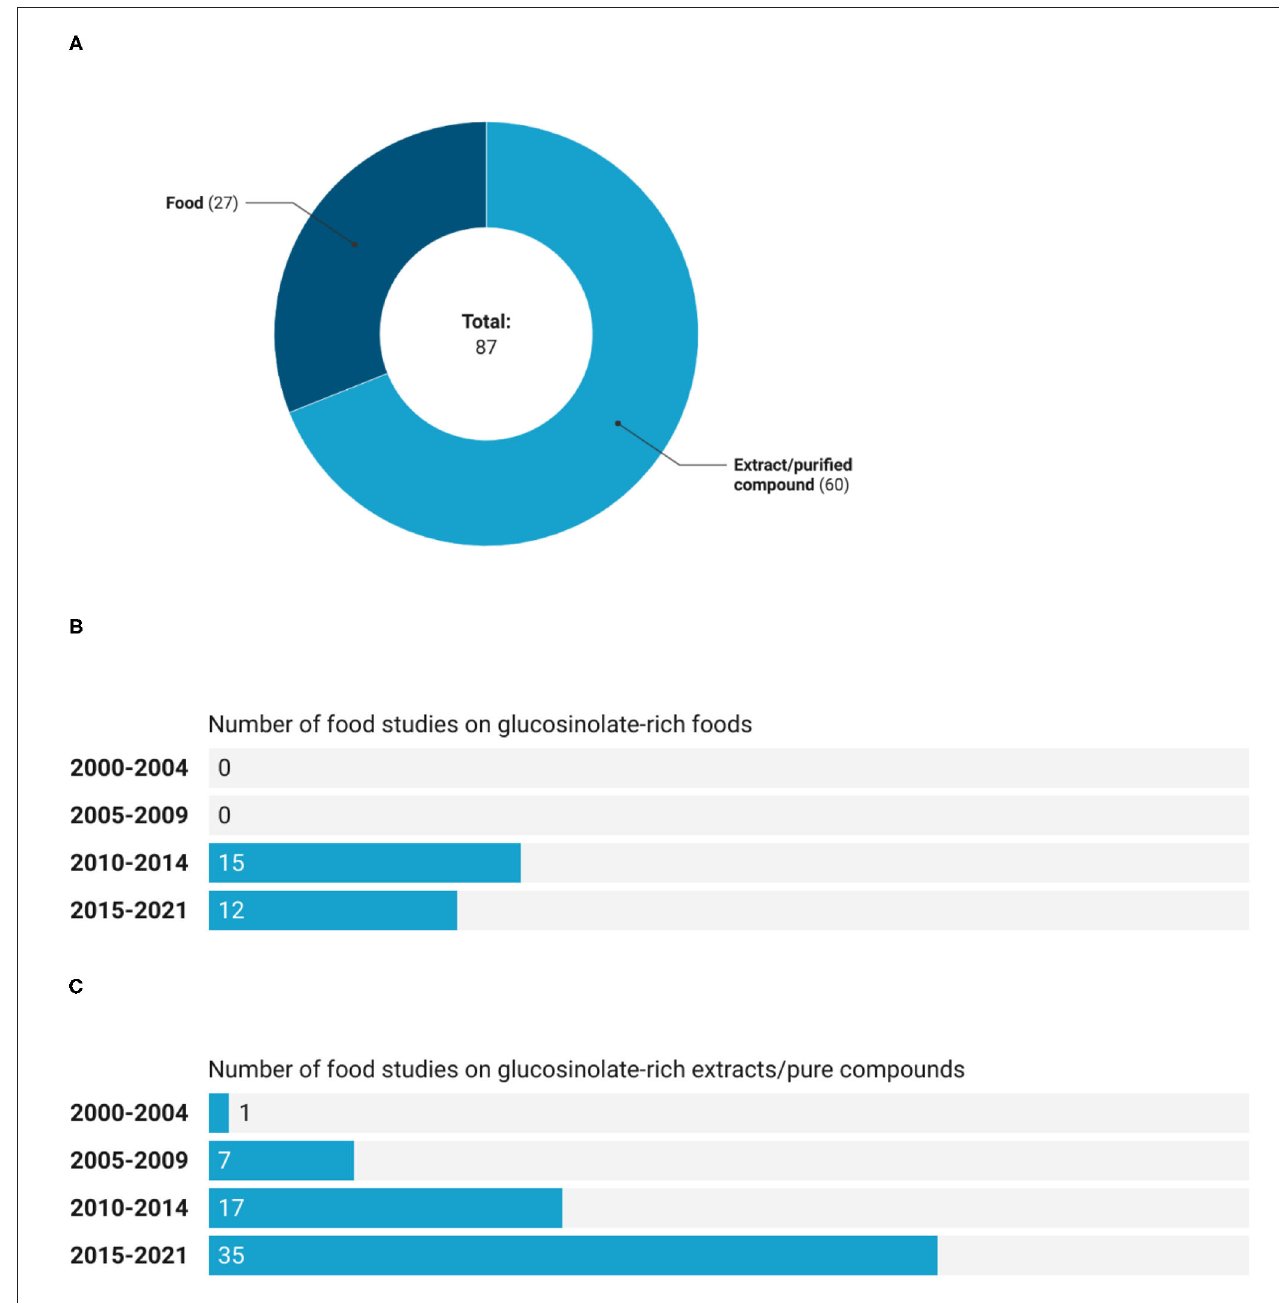
FIGURE 2 | Number (A) and trend of registered trials on GSL-rich foods (B) , and extracts or pure compounds (C)